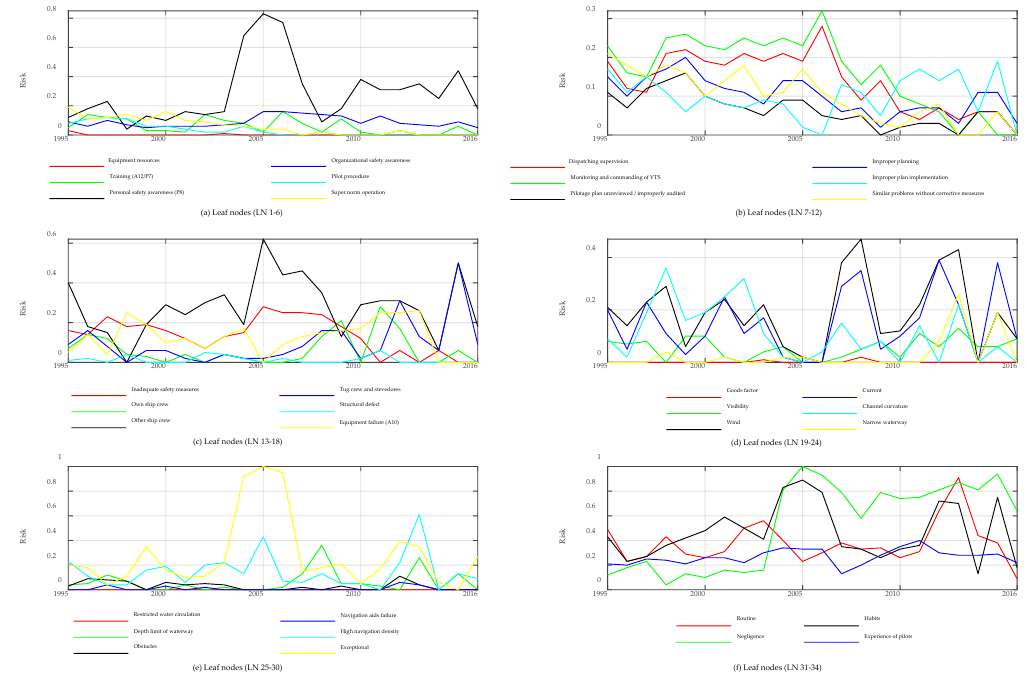
Figure 6. The risk of 38 leaf nodes (including 4 overlapping leaf nodes) from 1995 to 2016.